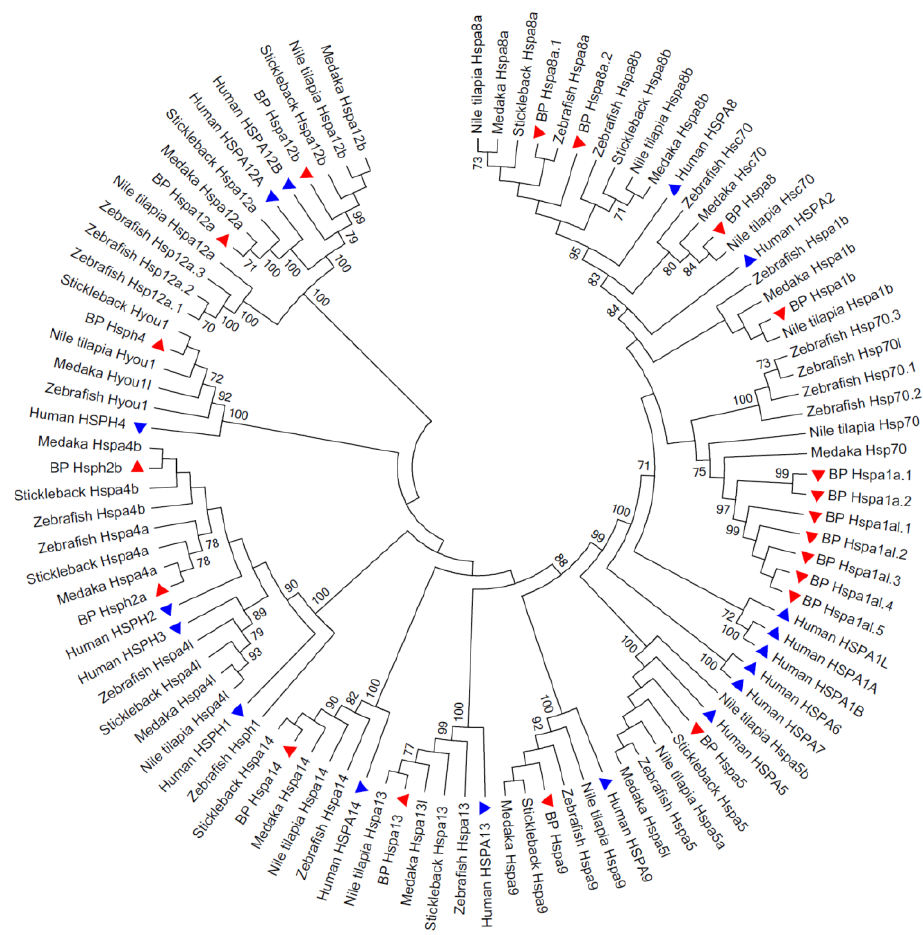
Figure 1. Phylogenetic tree of Hsp70 families from selected organisms. Hsp70s from B. pectinirostris and zebrafish are marked with red and blue triangles, respectively. Bootstrap supports of >70% in 1000 replicates are shown.